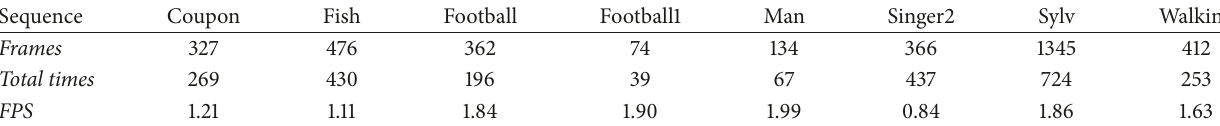
Table 1: Average frames per second